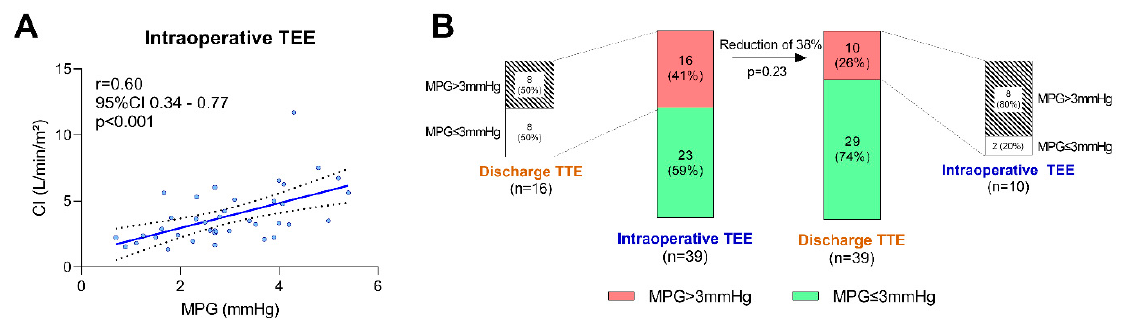
Figure 3. Characteristics of left atrioventricular valve (LAVV) mean pressure gradient (MPG) quan- tification following an AVSD repair using intraoperative transesophageal echocardiography (TEE). Non-invasively quantified cardiac index (CI) as a surrogate for the hemodynamic state shows a moderate-to-strong linear correlation with LAVV MPG at the intraoperative time-point ( A ). Proportions of patients with LAVV MPG above or below/equal to 3 mmHg quantified with intraoperative TEE and pre-discharge awake transthoracic echocardiography (TTE), respectively ( B ). 95%CI = 95% confidence interval, r = (Pearson’s) correlation coefficient.